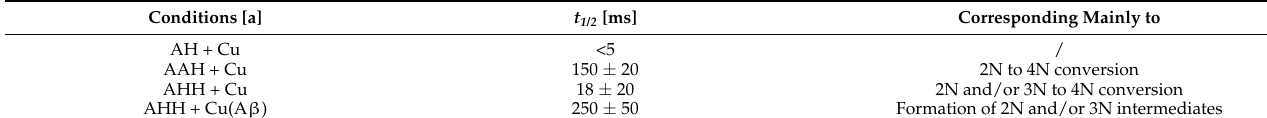
Table 1. Parameters for the kinetics of formation of Cu II –peptide complex.